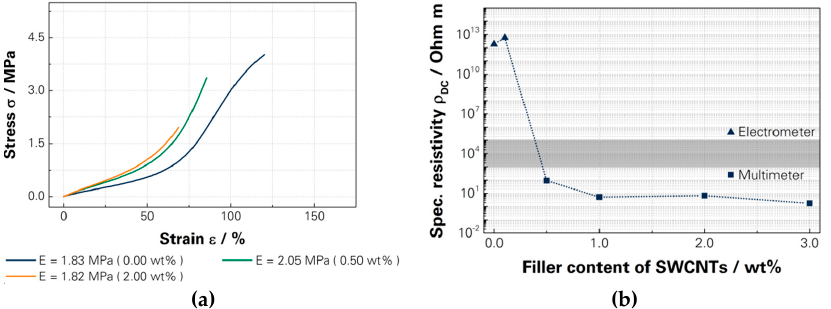
Figure 5. ( a ) Shift of the stress–strain behaviour [15]; and ( b ) the specific conductivity through the modification of SWNCTs.